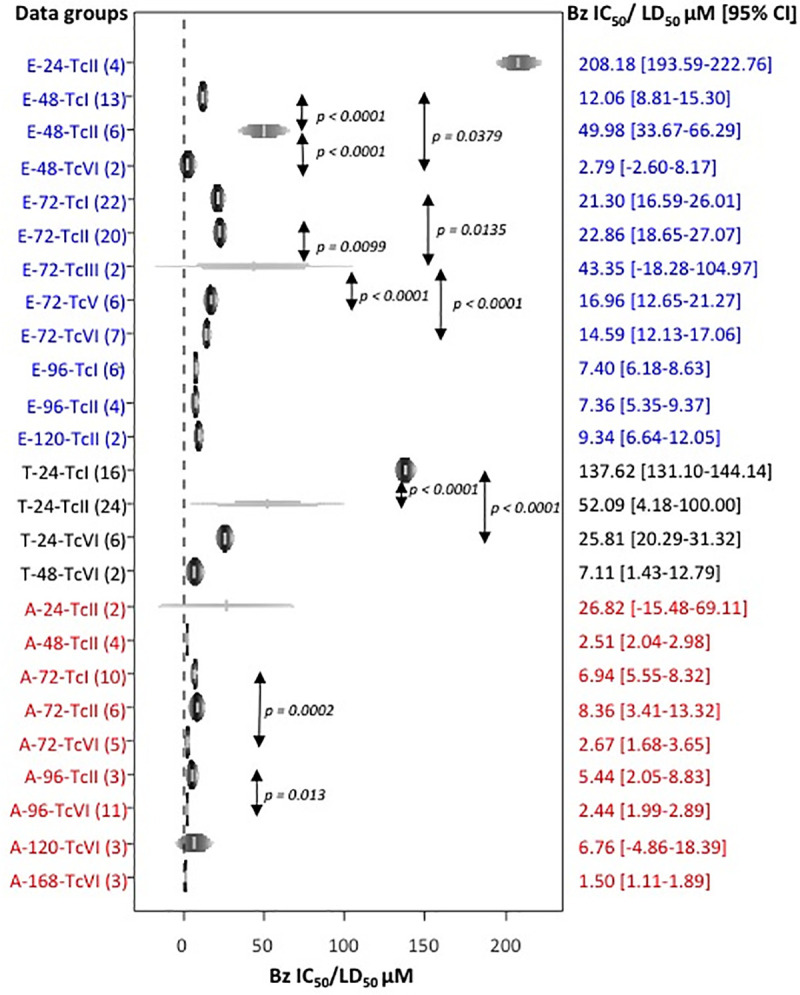
Meta-analysis of benznidazole LC50 and IC50 mean values.Rainforest plot diplaying mean LC50 and IC50 values for benznidazole (Bz) and their 95% confidence intervals (x-axis) estimated by meta-analysis. Combined assays per parasite stage [“E” for epimastigote (blue), “T” for trypomastigote (black) and “A” for amastigote (red)], drug incubation times and DTUs are shown (y-axis); the number of assays per group is displayed in brackets. Mean values and confidence intervals (CI) are shown at the right side of the figure. For comparison of results between DTUs, statistics were applied only between groups belonging to the same parasite stage-incubation time; only significant p-values (< 0.05) are reported.